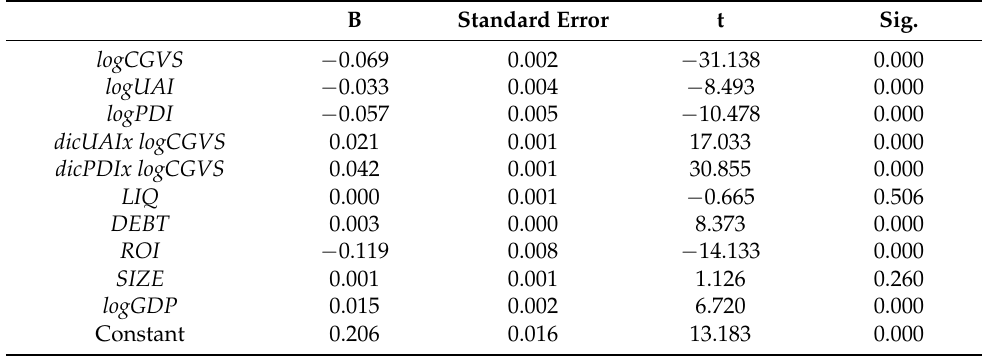
Table 5. Linear regression results (Equation